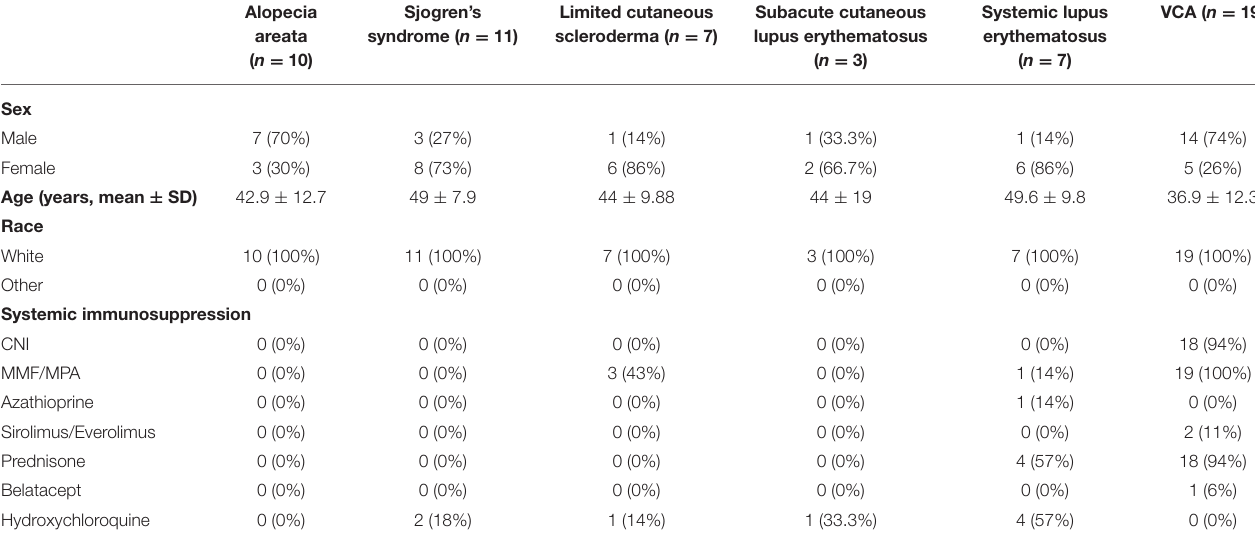
TABLE 5 | Autoimmune skin disease patients’